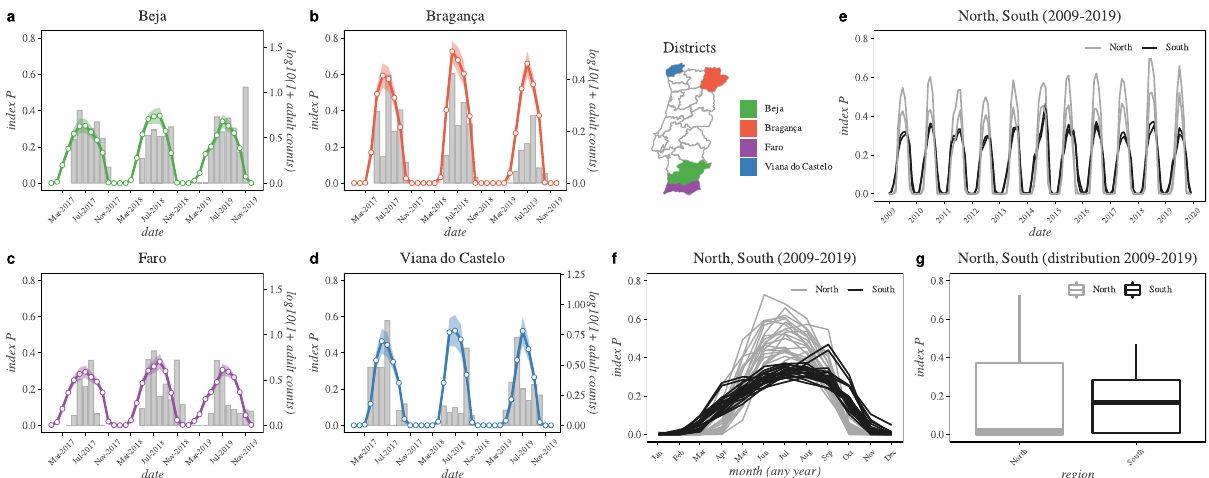
Fig. 4 Monthly REVIVE Culex pipiens counts in Portugal versus estimated transmission potential index P (2017 – 2019). a – d Present the monthly time series for log 10 ð mosquitopopulationsize þ 1 Þ (grey bars) and mean (colored lines) and standard deviation (coloured areas) for four districts: two from the south ( a for Beja in purple, c for Faro in purple) and two from the north ( b for Bragança in red, d for Viana do Castelo in blue). The map panel presents all districts, coloured by their location. e Shows the mean index P for all districts 2009-2019 (north in grey and south in black). f Shows the seasonal index P per month from e independently of year. g is the distribution of index P across the period 2009 – 2019. For the estimation of the index P , the monthly mean of the climate variables was used per district. The North-South divide is the same as de fi ned in the legend of Fig.